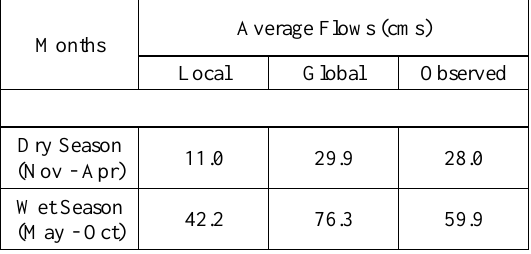
Table 1. Monthly average flows and seasonal means.